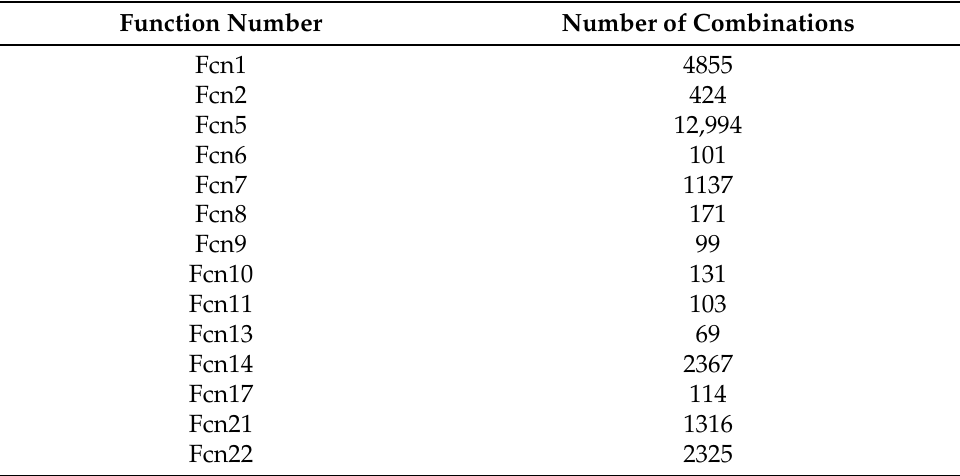
Table 3. Objective functions from the first case and their respective number of combinations that achieved the required fitness with high effectiveness (cid:99) SR ≥ 0.95 are summarized.